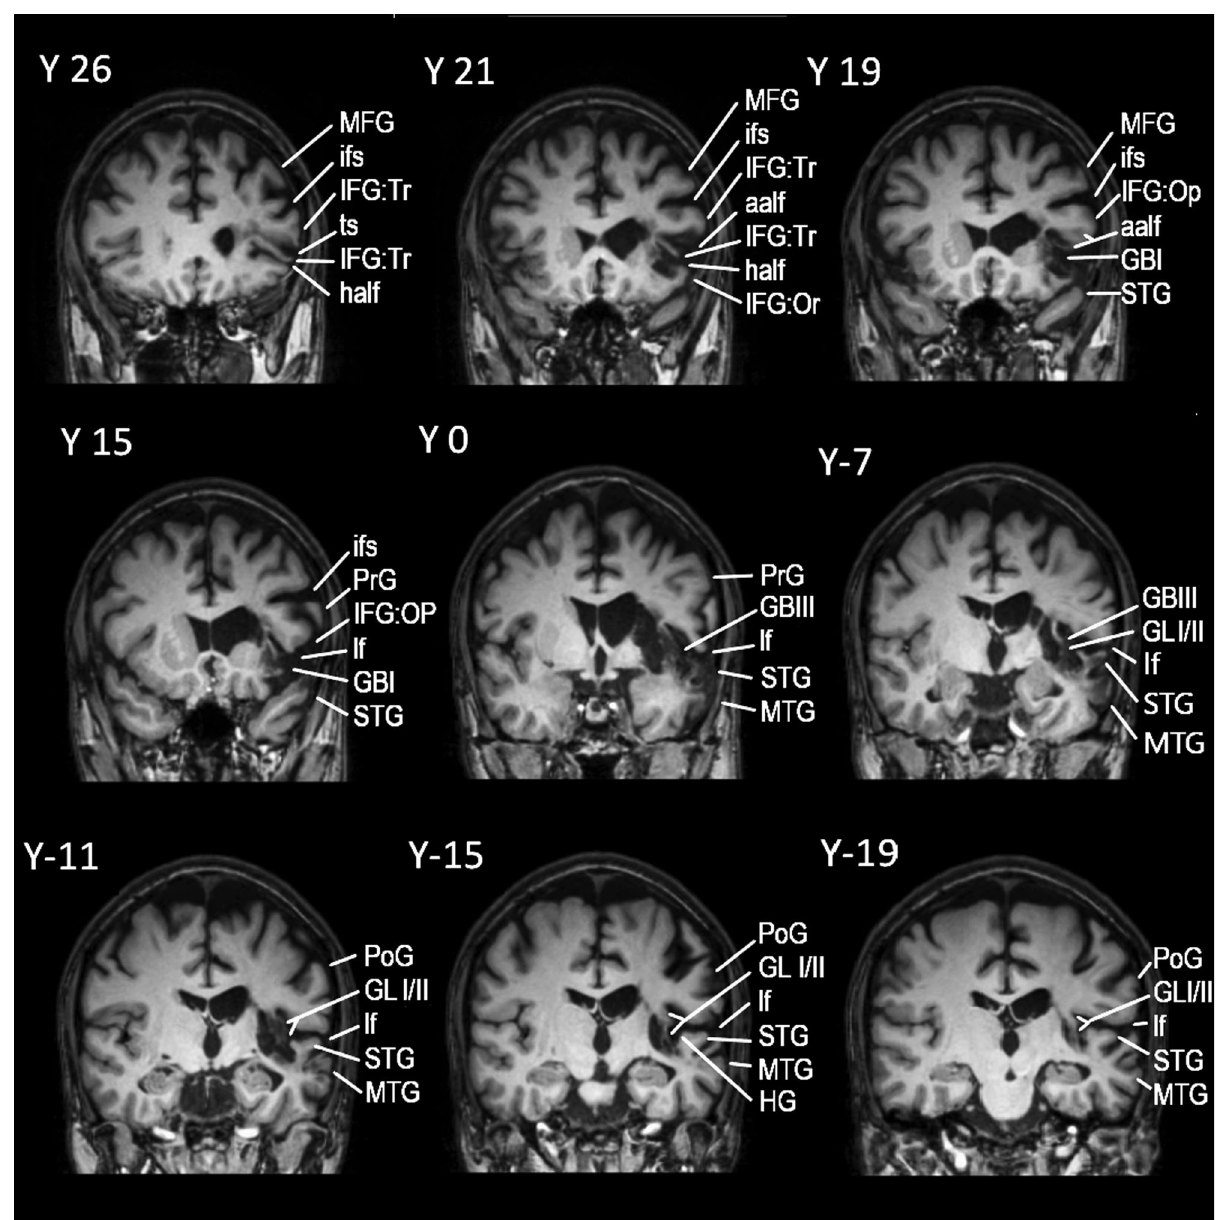
Fig. 1 Successive coronal MRI images in MNI stereotaxic coordinates (Y) depicting the lesion of patient AA. The lesion appears at Y35 and continues as far as Y20, including a part of the pars triangularis (area 45) and the white matter below (see Y26, Y21). At Y19, the lesion also includes part of the caudate, the adjacent internal capsule (IC), the external capsule (EC), and the temporo-frontal extreme capsule fasciculus (TFexcF), just below insular gyrus Brevis I (GBI). Subcortically, there is damage to the claustrum, putamen, and the anterior part of the insula (GBI) under which courses the TFexcF. From Y15 to Y7, the lesion includes a small part of the anterior STG. Moving on posteriorly, between Y3 and Y-3, one can observe damage to the TFexcF which courses between the claustrum and the anterior insula (gyrus Brevis III; GBIII), the STG and a small part of MTG, including both banks of the superior temporal sulcus (sts) (see Y0). At Y-7, one observes that the lesion is located anterior to the level of the sulcus acousticus (sa) that lies on the lateral STG (see also Fig. 2). Subcortically, the lesion includes part of the caudate, IC, EC, TFexcF between the claustrum and insular gyrus Brevis III and gyrus Longus I & II, STG, sts and the whole MTG. The temporal lesion is visible as far posterior as Y-15 where it is restricted to the insula, caudate, putamen, claustrum, EC, TFexcF, and at Y-19 to putamen and lower insula, leaving Heschl ’ s gyrus and the surrounding temporal areas completely spared. Posterior to Y-20, no lesion is detected. Brain areas are topologically de fi ned according to the atlas of the morphology of the human cerebral cortex in the MNI Stereotaxic Space 67 . aalf ascending anterior ramus of the lateral fi ssure; GBI gyrus brevis I of insula; GBIII gyrus brevis III of insula; GLI gyrus longus I of insula; GLII gyrus longus II of insula; half horizontal ascending ramus of the lateral fi ssure; HG Heschl ’ s gyrus; IFG:Tr inferior frontal gyrus, pars triangularis; IFG:Op inferior frontal gyrus, pars opercularis, Or pars orbitalis; Tr pars triangularis; ifs inferior frontal sulcus; lf lateral fi ssure; MFG middle frontal gyrus; MTG middle temporal gyrus; PoG postcentral gyrus; PrG precentral gyrus; sts superior temporal sulcus; ts triangular